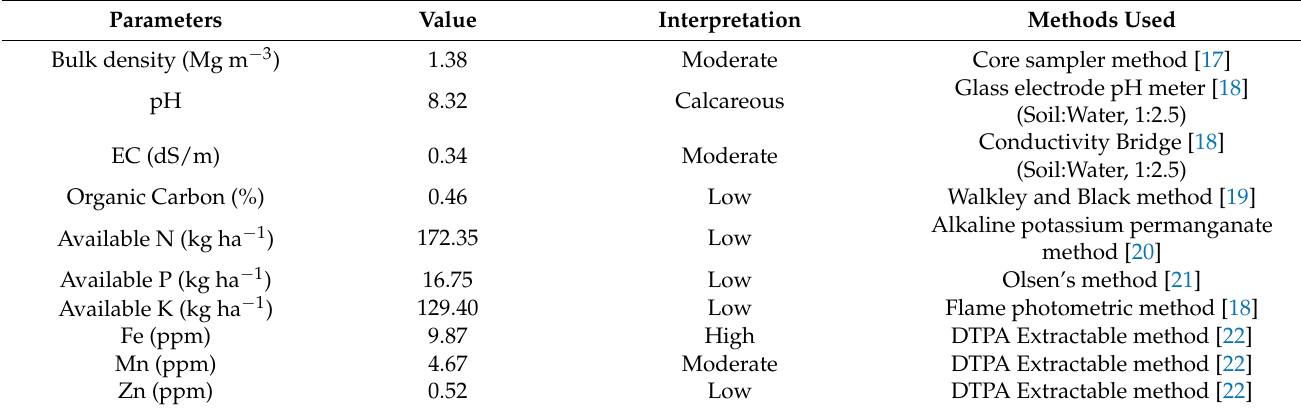
Table 1. Initial soil properties of the experimental site.